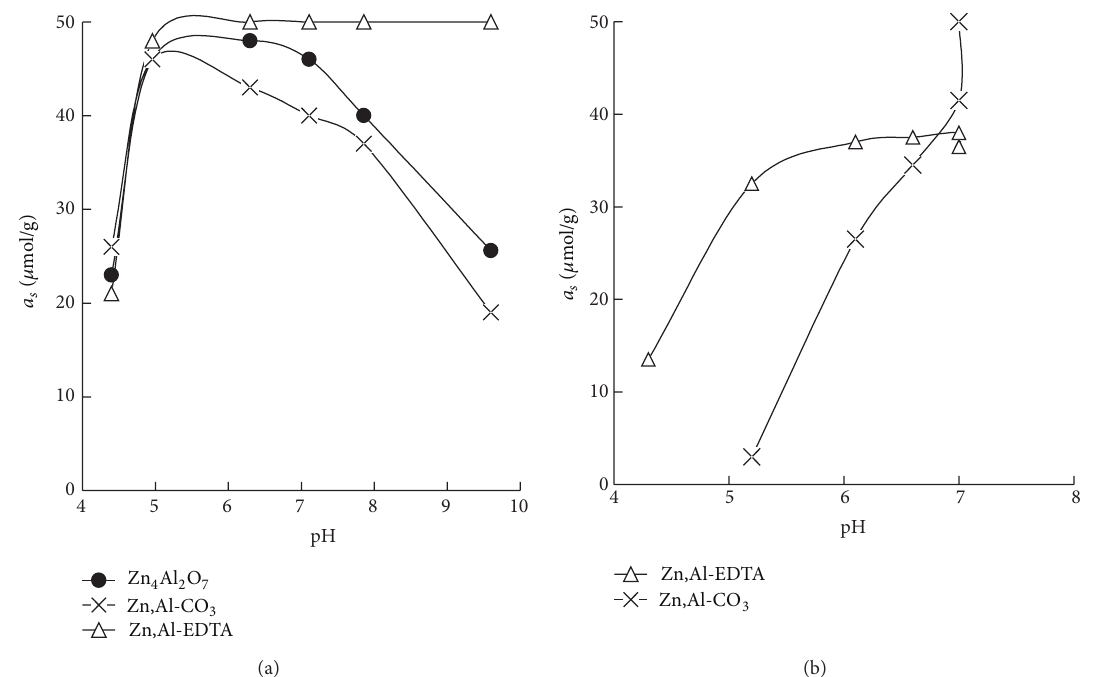
= 100 𝜇 mol/g, 𝑉 U ( VI )